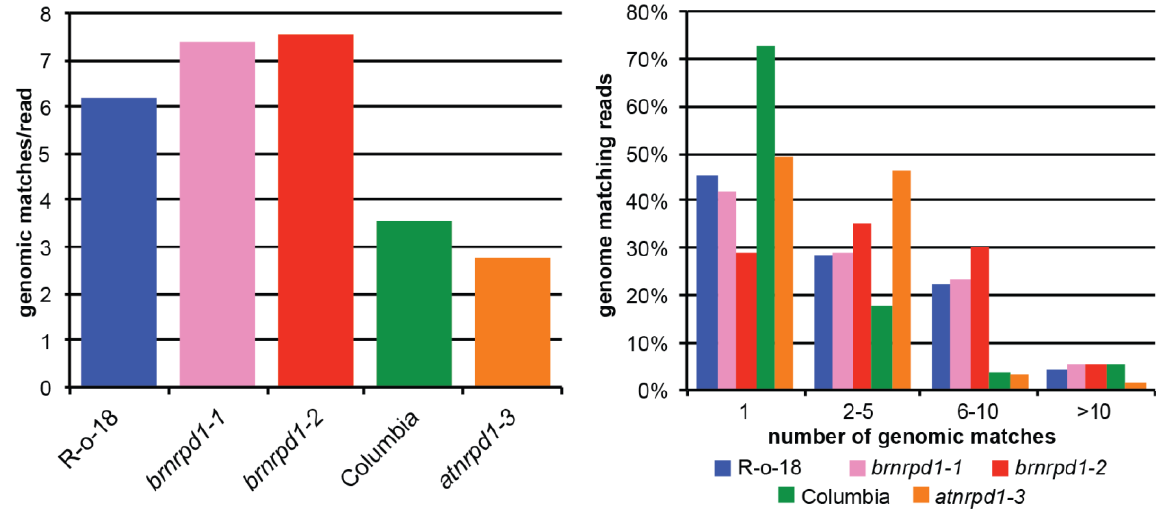
Figure 4. Genomic repetitiveness of small RNA transcriptomes in B. rapa and Arabidopsis . Average genomic matches per read ( left ) and distribution of genomic repetitiveness ( right